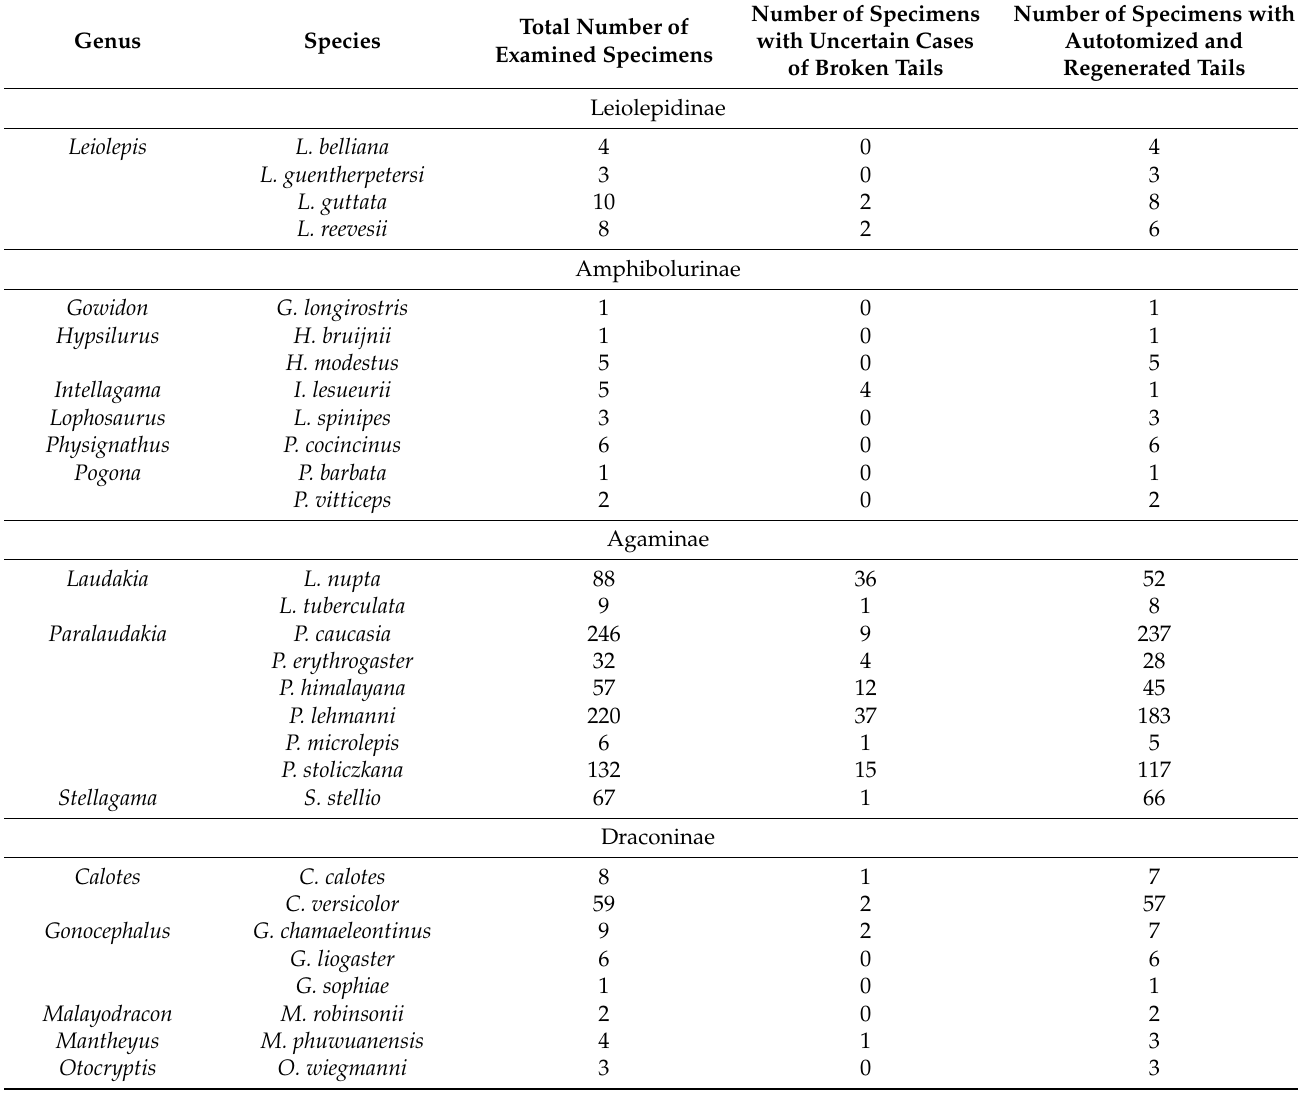
Table 1. The number of analyzed museum specimens in the herpetological collections of the ZISP RAS and ZMMSU (sample size). Genus Species